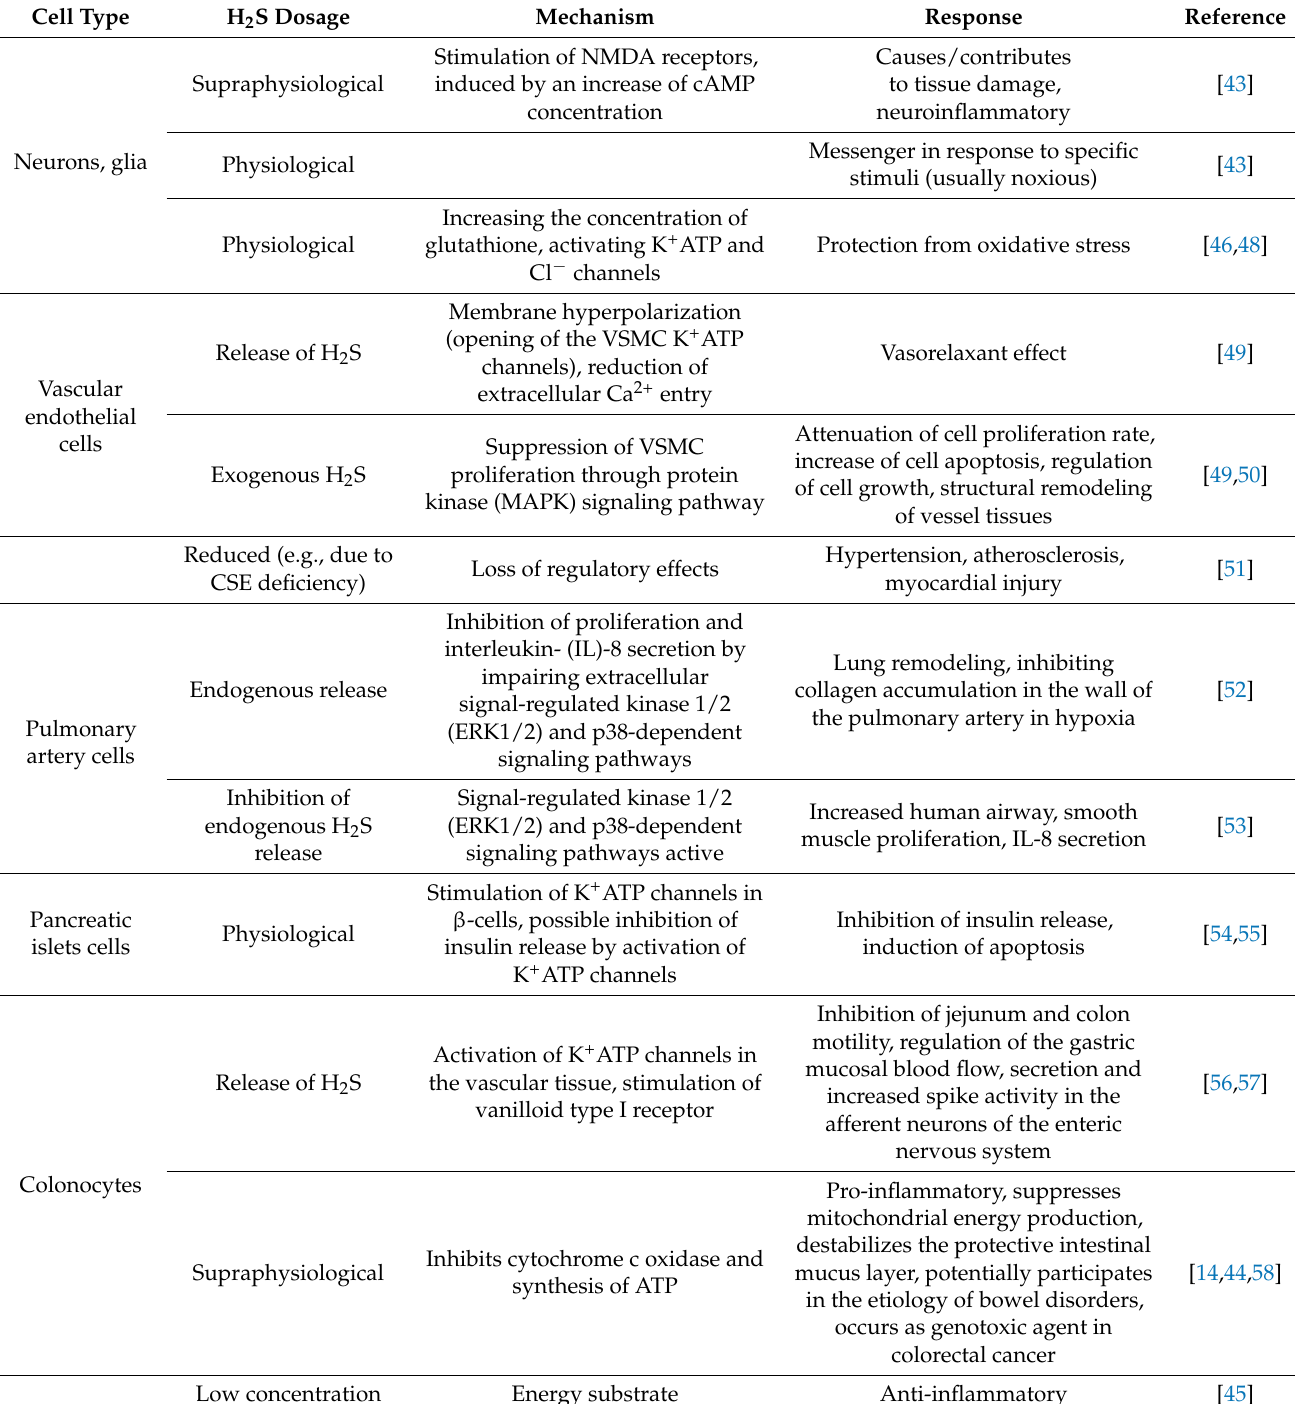
Table 2. Reported effects of H 2 S in selected cell